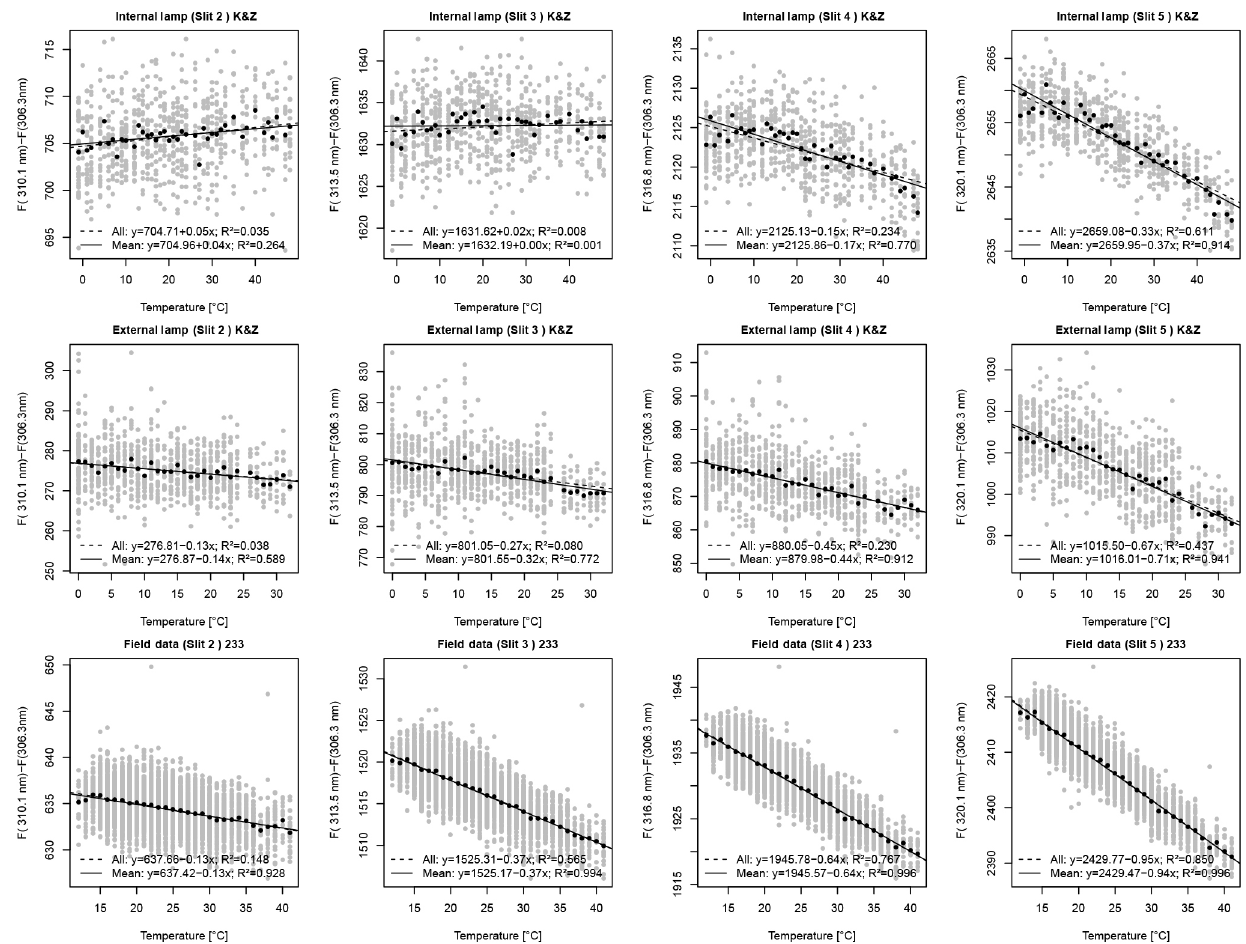
Figure 9. K&Z experiment. Linear regression between relative Brewer data (slits 2, 3, 4 and 5 relative to slit 1) and temperature. Coefficients are determined from internal and external lamp measurements in the temperature chamber and from field data. Linear regression using individual measurements (grey points) is represented by dashed lines, while solid lines represent the linear regression when using average values at each temperature.